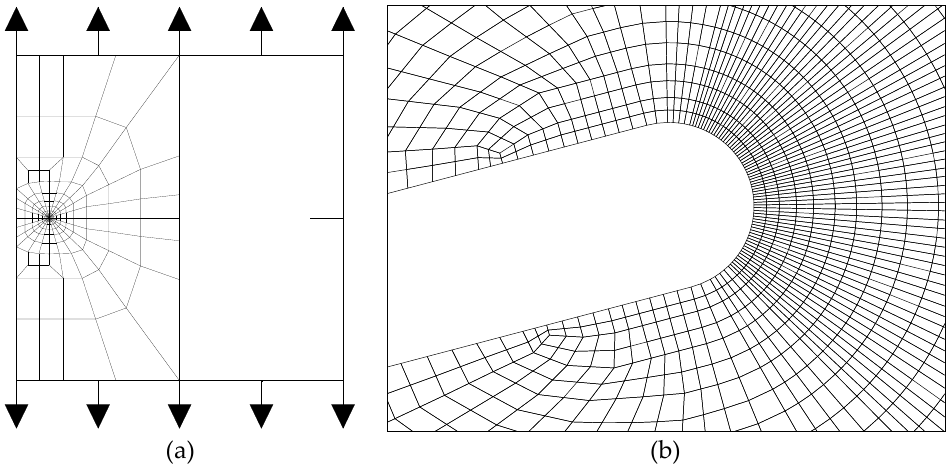
Figure 1. Finite element mesh: ( a ) general view on the full plate; ( b ) crack tip detail.